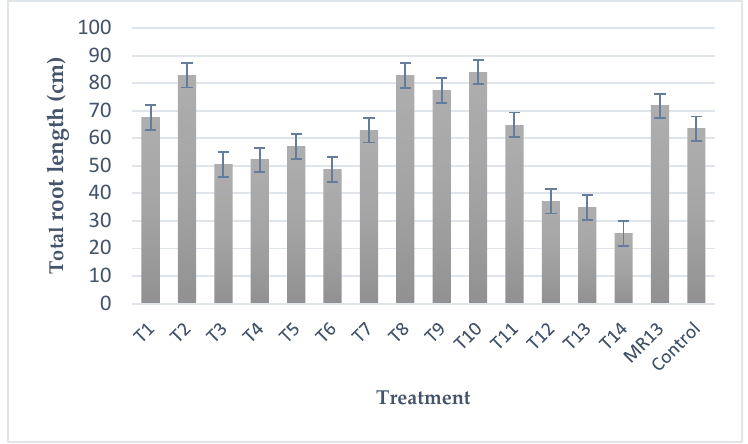
Figure 4. The root length of chilli seedlings treated with endophytic bacteria and moringa leaf extract using various extraction methods. The values are an average of five independent measurements.